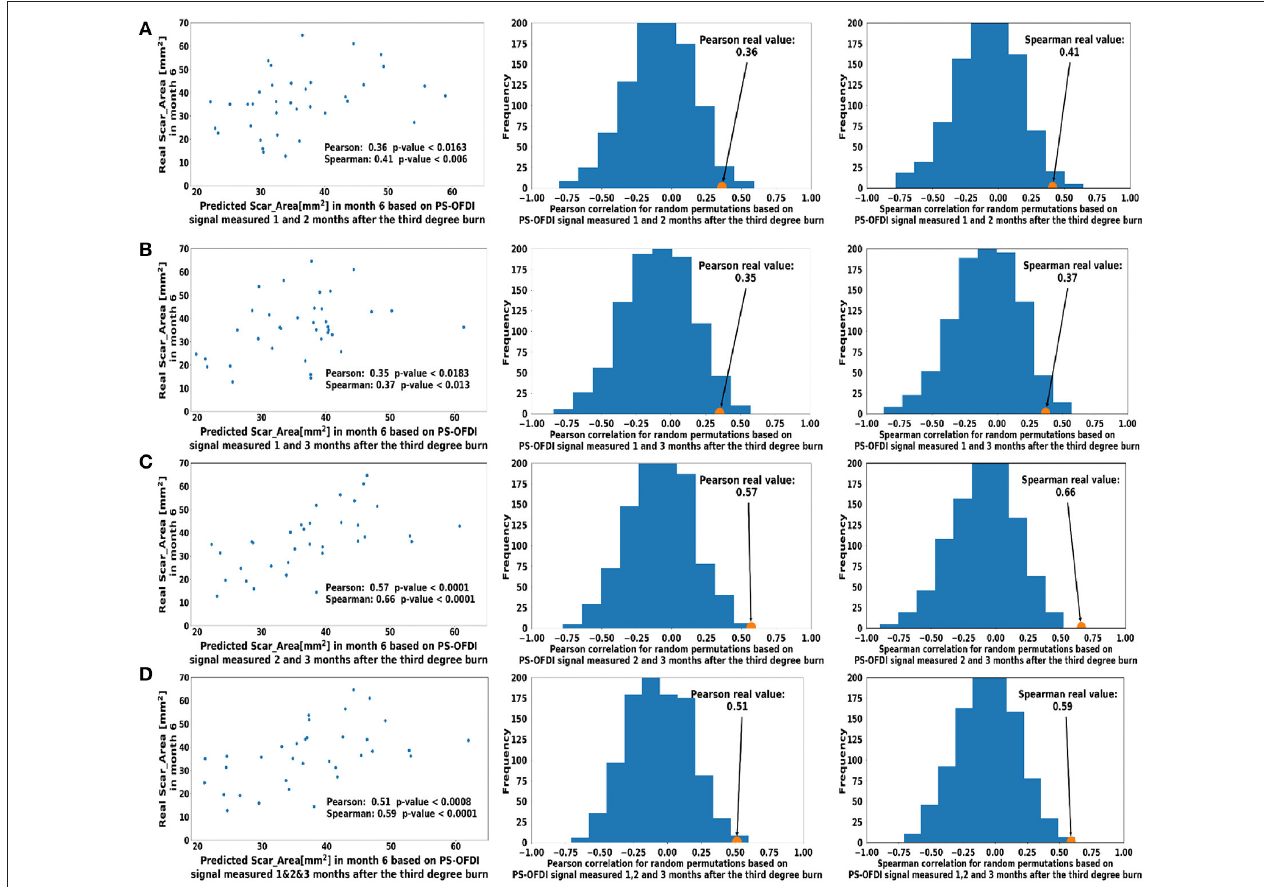
FIGURE 4 | Predicted scar area at month 6 based on multiple measurements taken at (A) . Month 1 and Month 2 (B) . Month 2 and Month 3 (C) . Month 1 and 3 (D) . Month 1, 2, and 3 after the third-degree burn injury. The control histograms of the correlation coefficients corresponding to randomly shuffled measurements appear on the right-hand side of each panel.